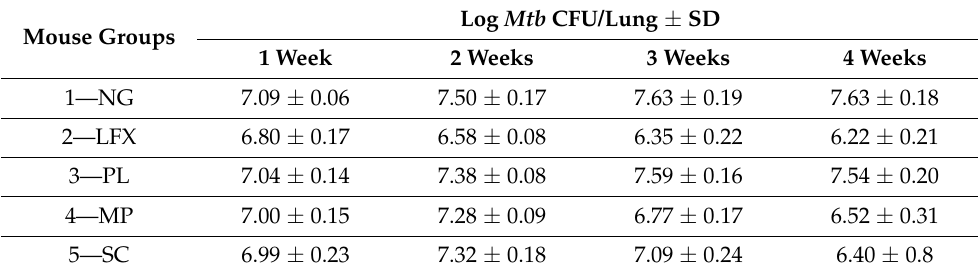
Table 4. Multiplication of Mtb and efficacy of the anti-tuberculosis therapy in mice for 1, 2, 3, and 4 weeks after transplantation. Mouse